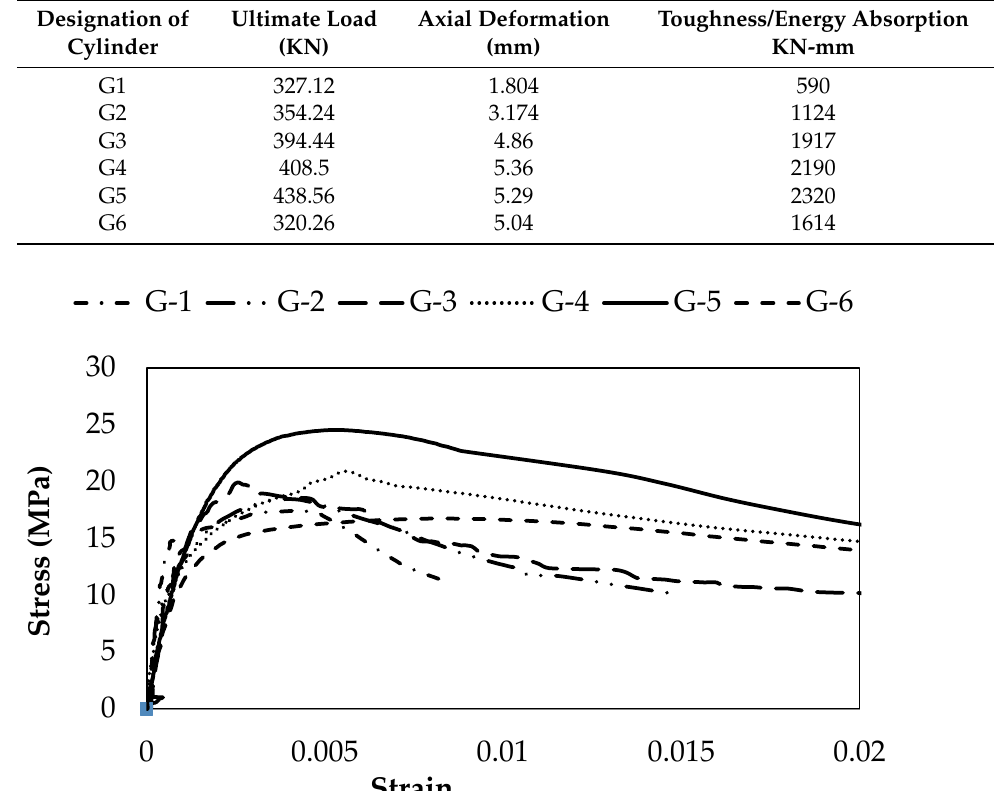
Figure 8. Compressive strength test result of cylindrical specimens and percentage increment in compressive strength. Table 6. Axial behavior of unconfined concrete.